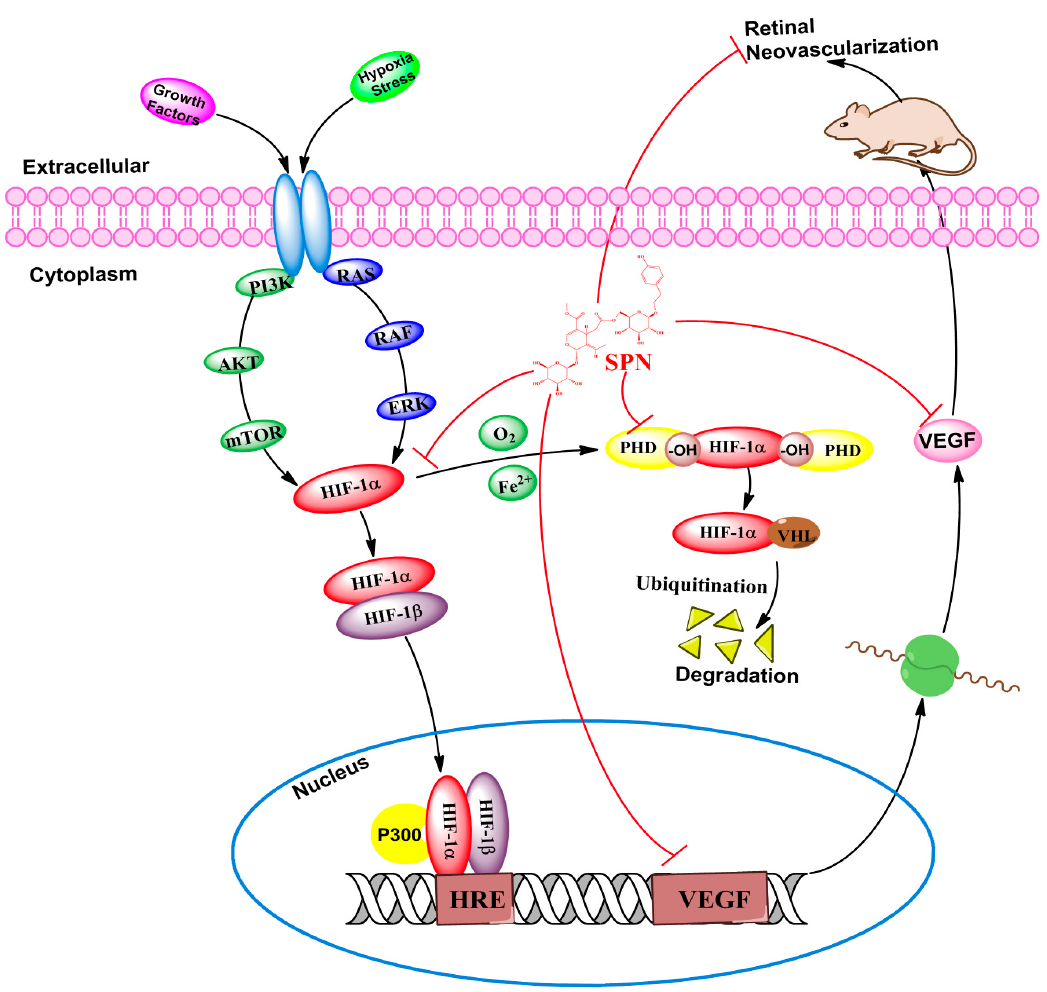
Figure 8. Effect of SPN on hypoxia-induced retinal angiogenesis.